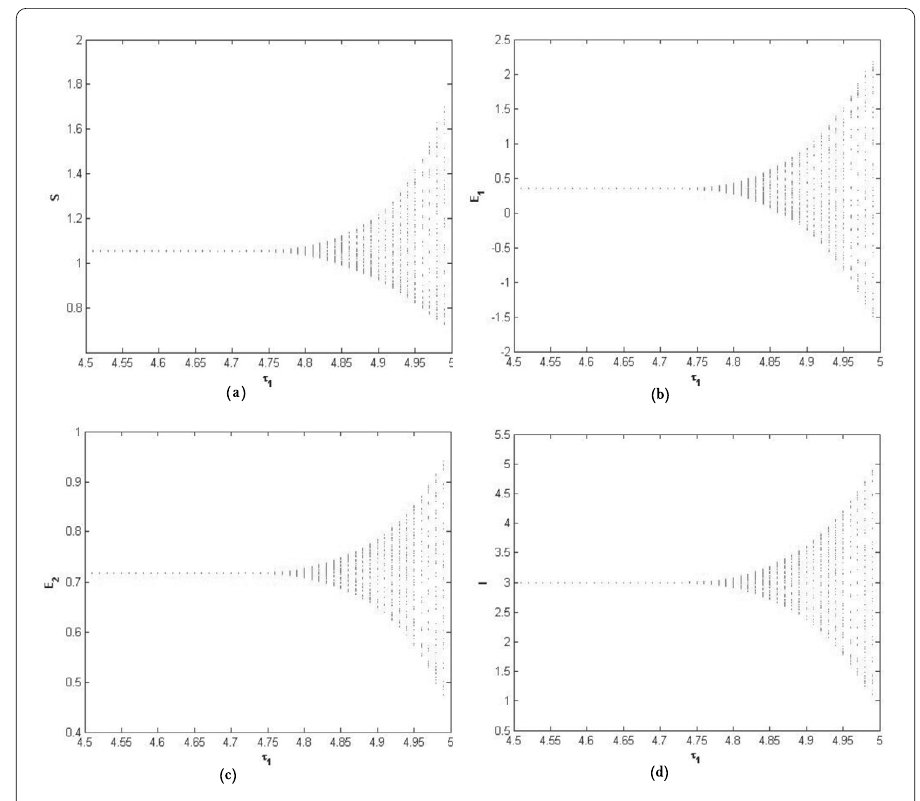
Figure 1 The bifurcation diagram with respect to τ 1 when τ 2 =